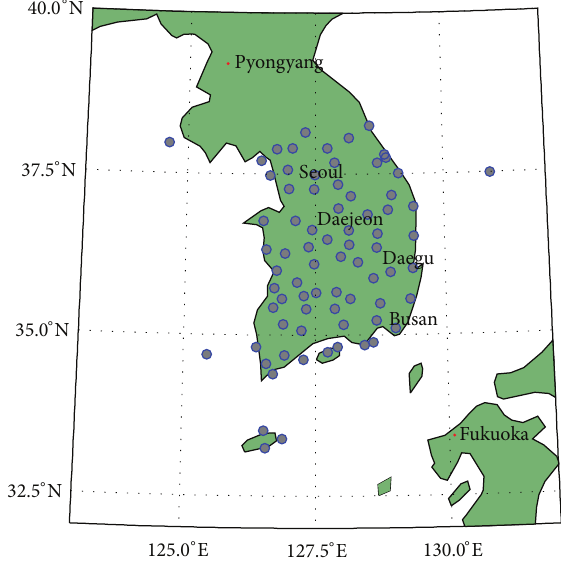
Figure 6: The locations of the employed 74 rain gauges in Republic of